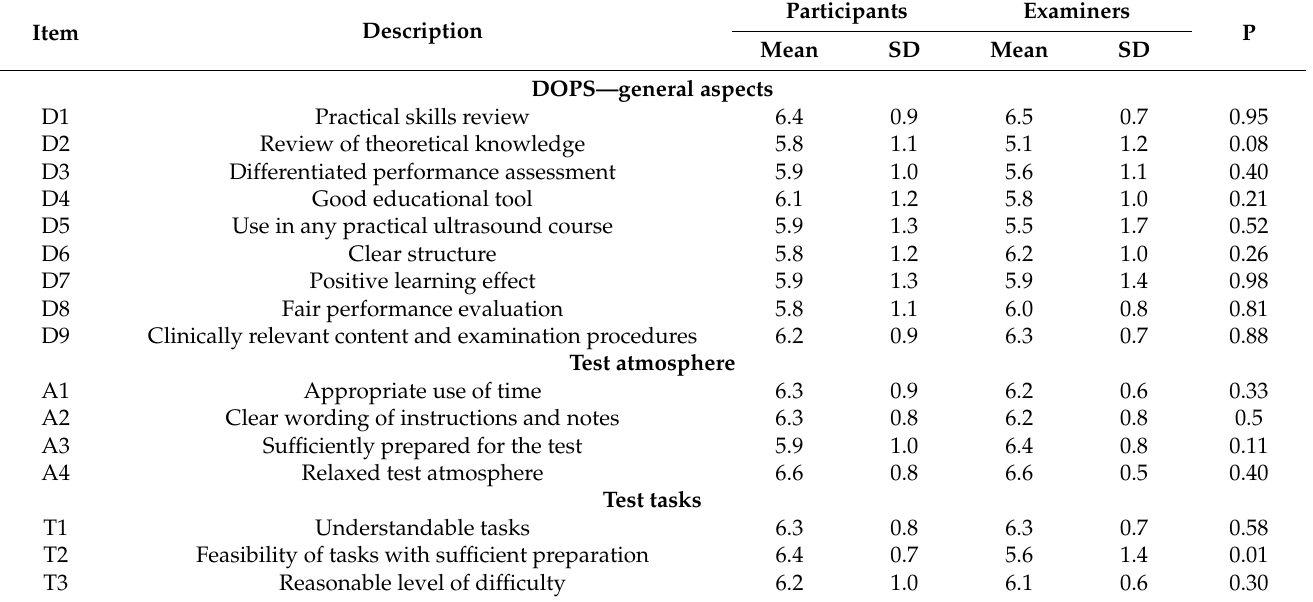
Table 2. Evaluation results of identical items between participants and